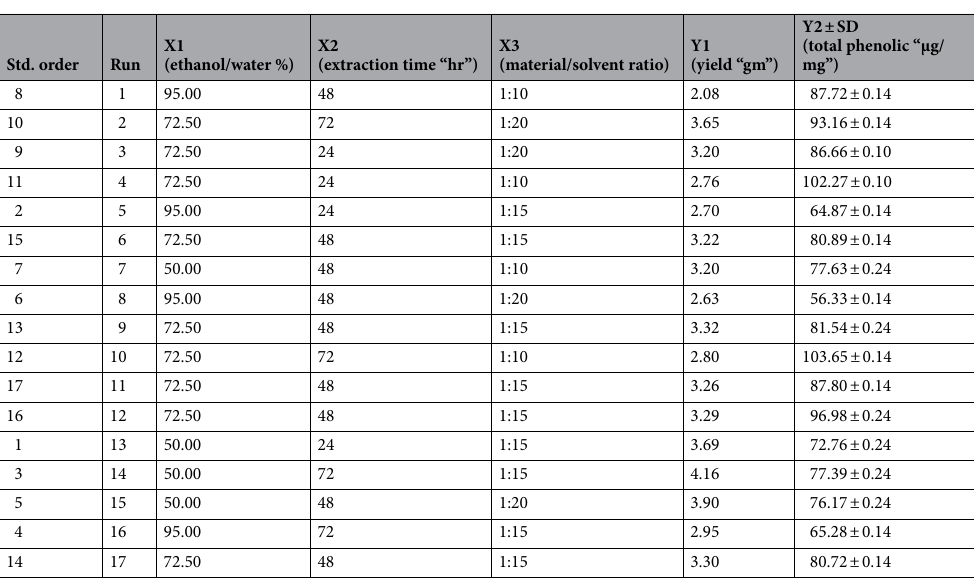
Table 3. The Box-Behnken response surface design and corresponding response values.